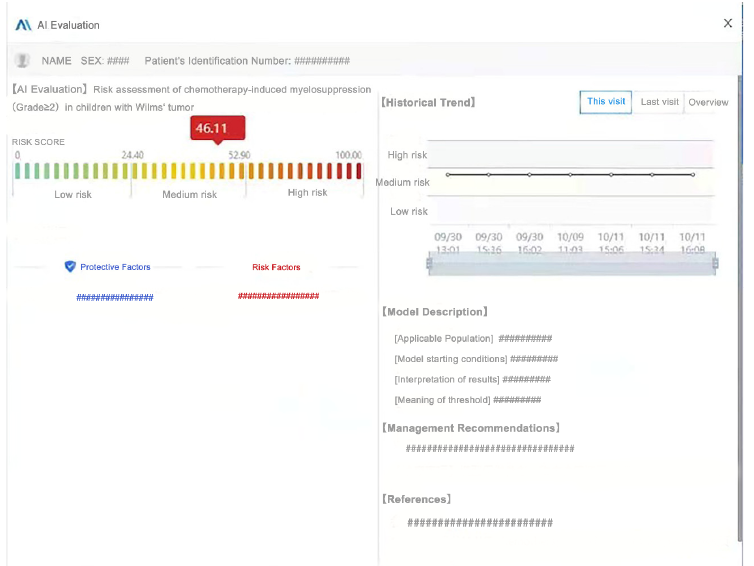
Figure 5. Decision curve analysis of the six ML models.